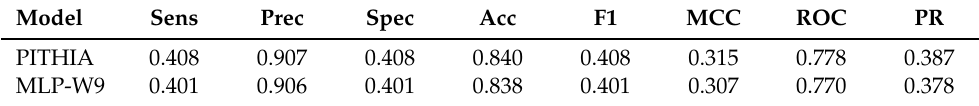
Table 6. Comparison of two models, PITHIA (W9H1A64) and MLP-W9, on dataset Dset_448.